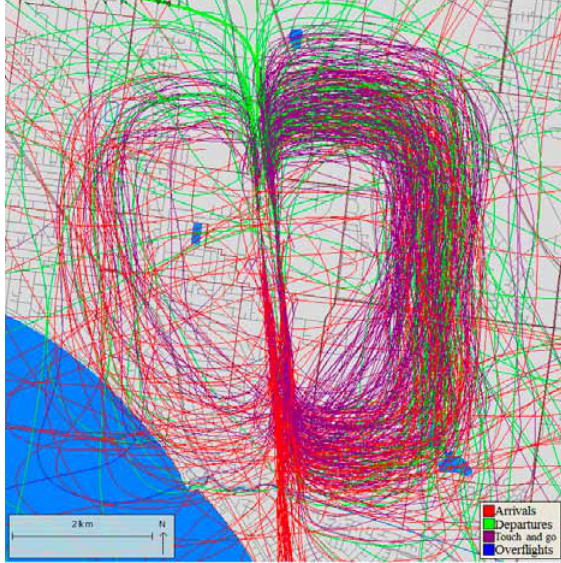
Fig. 3. Typical operations from Runway 17 (8 th September